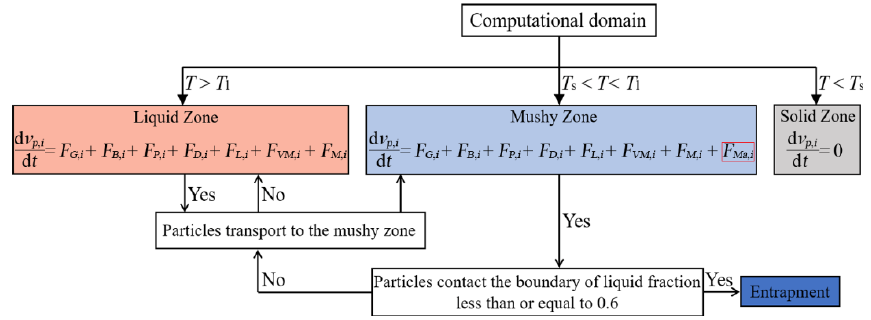
Figure 5. Schematic diagram of particle transport process in the CSP and FTSR molds.